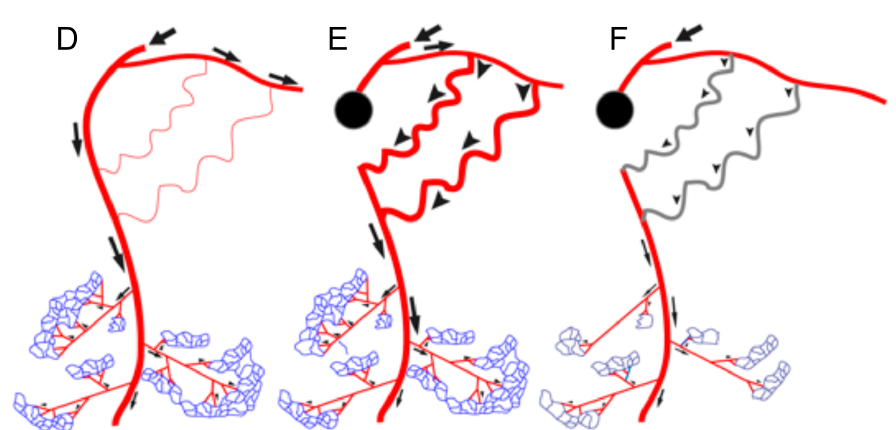
Figure 2. Interdependence of arteriogenesis and angiogenesis in healthy and arteriosclerotic vessels. ( A ): Schematic representation of the arterial network. Arterial occlusion disrupts blood flow to the microcirculation. ( B ): In the presence of the proximal occlusion, stimulation of angiogenesis in the microcirculation will not result in restoring peripheral blood flow. ( C ): Restoring blood flow upon occlusion requires the recruitment of native collaterals or de novo formation of collaterals that can bypass the occlusion in the arterial network. ( D ): Schematic representation of the arterial network in the leg with native arterial collaterals. Flow distribution indicated by arrows. ( E ): Occlusion in the main feed artery results in rerouting of blood flow and flow driven outward remodeling of pre-existing native arterial collaterals (arrowheads). ( F ): Diabetes and hypertension associated with rarefaction of small arterioles and capillary networks (indicated in dark blue) and impaired (flow driven) outward lumen remodeling (arteriogenesis) of arterial collateral networks (impaired collaterals in grey). In this scenario, only targeting upstream collaterals is not sufficient to achieve increased oxygen and nutrient delivery to the periphery. The perfusion of the microcirculation needs to be improved as